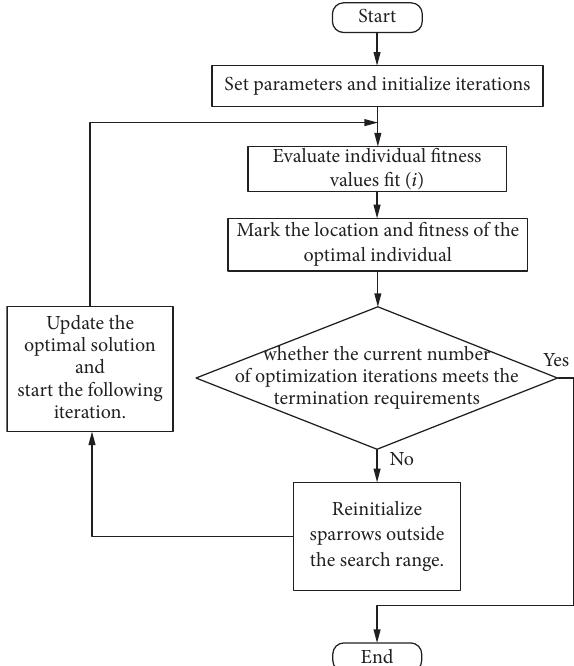
Figure 2: The flow chart of parameter-optimized DBN based on